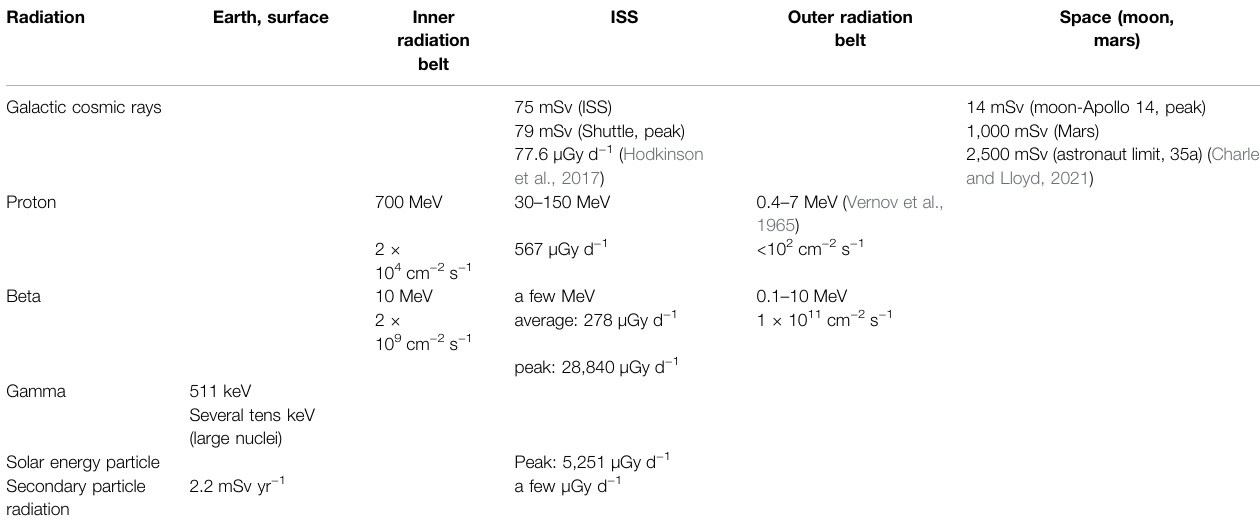
TABLE 3 | Radiation characteristics on Earth and space at different distance from Earth.